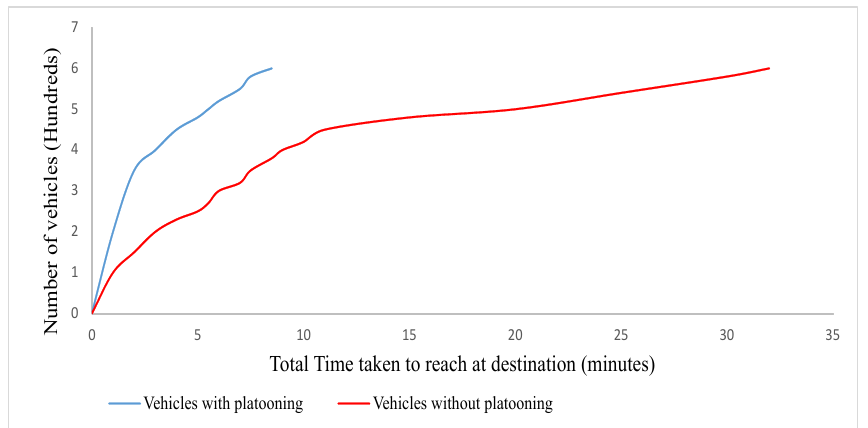
Figure 6. Comparison of vehicle’s timing with and without platooning. In Figure 7, the results of multiple scenario implementation are shown. The graph shows the computation time taken by 600 vehicles to reach their destinations. The green line in the graph shows the scenario when the leader vehicle fails; the red line shows the scenario when multiple platoons come together, that is, the merging of platoons; and the blue line shows the scenario when some obstruction comes within platoons causing the splitting of the platoons. The results show that the blue line takes more time, almost 25 min, for 600 vehicles to reach their destination. This means that, if some obstruction